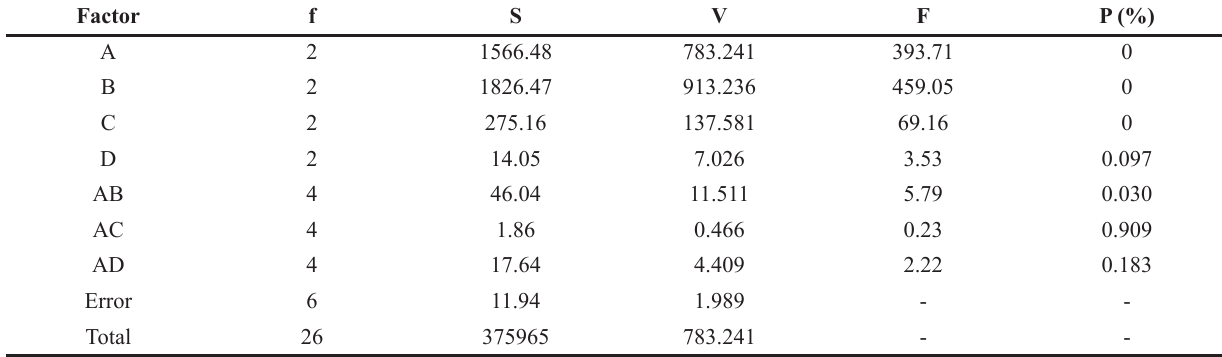
Table 2. The ANOVA results in CV + removal efficiency with modified